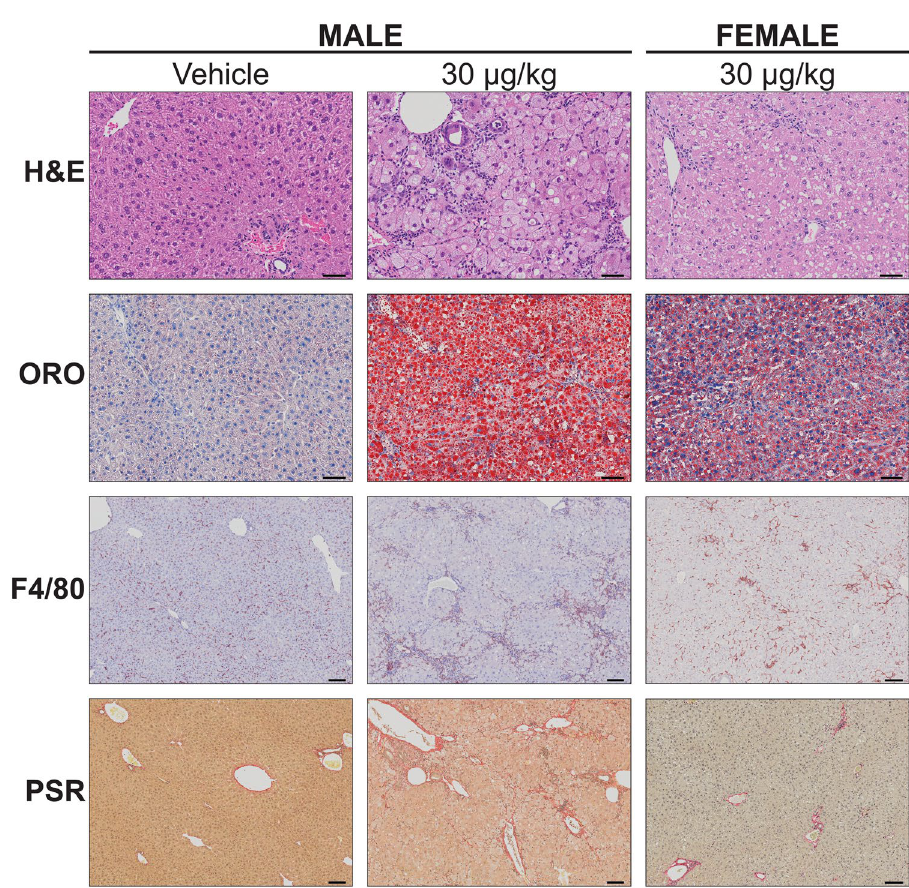
Figure 1. Histological evaluation of livers from male and female C57BL/6 mice orally gavaged with sesame oil vehicle or 30 µ g/kg TCDD every 4 days for 28 days. Livers were stained with hematoxylin and eosin (H&E) for general assessment, Oil Red O (ORO) for neutral lipids, F4/80 for macrophages, and Picrosirius Red (PSR) for collagen deposition. Scale bars represent 50 µ m for H&E and ORO, and 100 µ m for F4/80 and